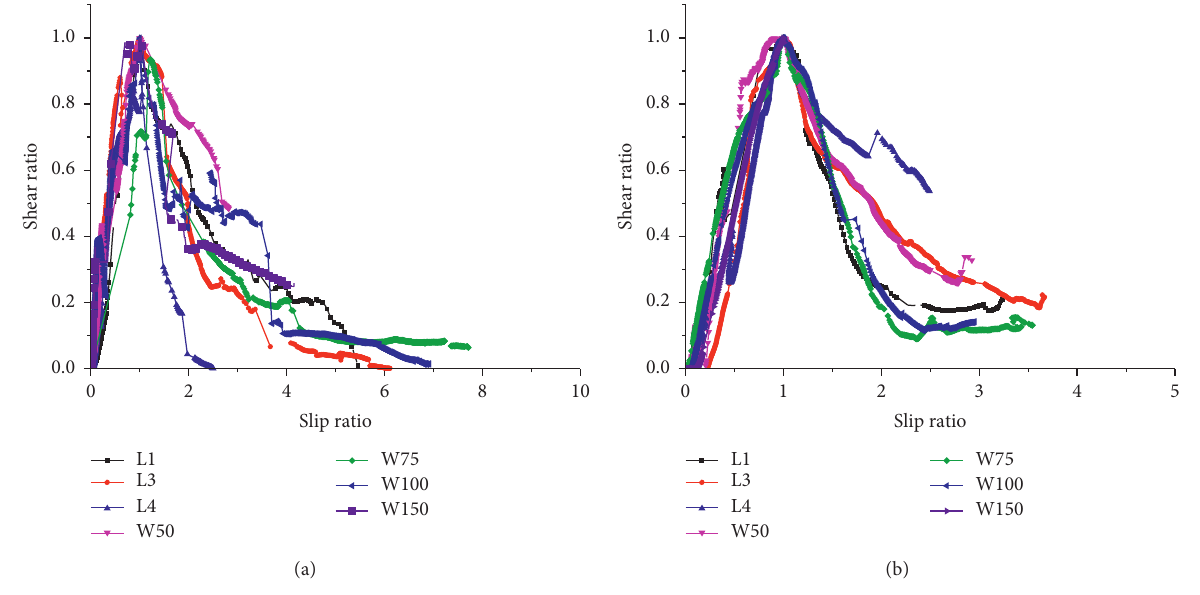
Figure 9: Normalized bonding stress-slip curve of the (a) nonanchored area and (b) anchored area.